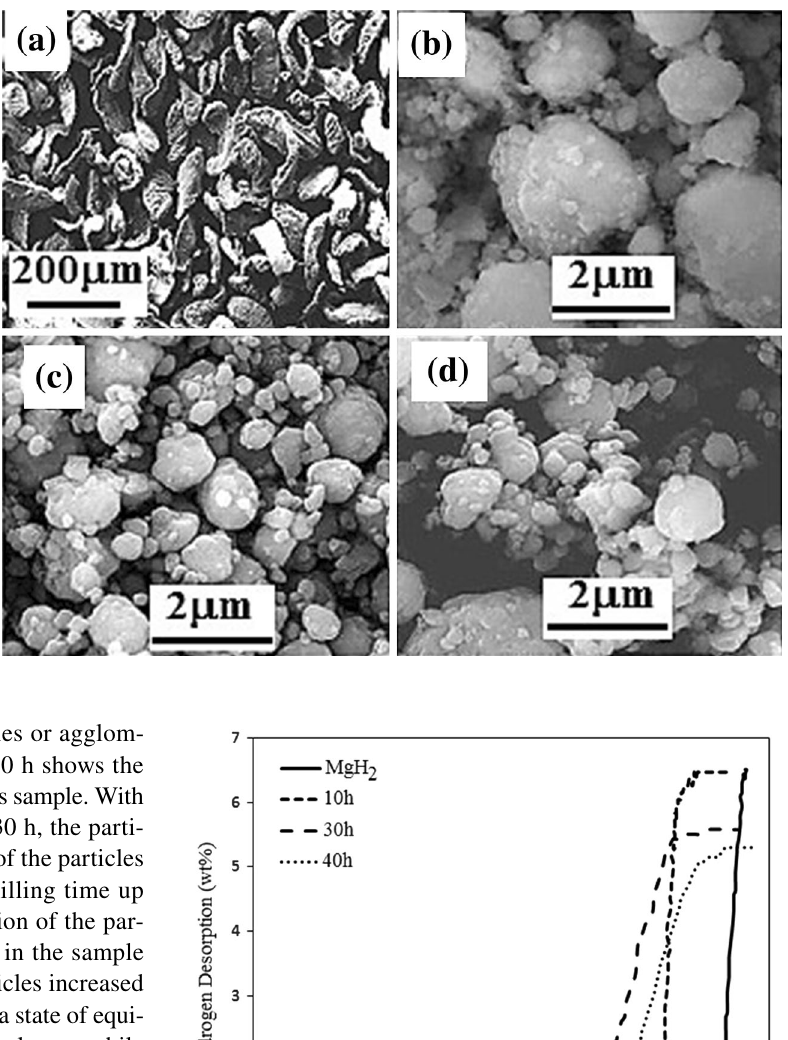
Fig. 4 Scanning electron microscopy (SEM) images of